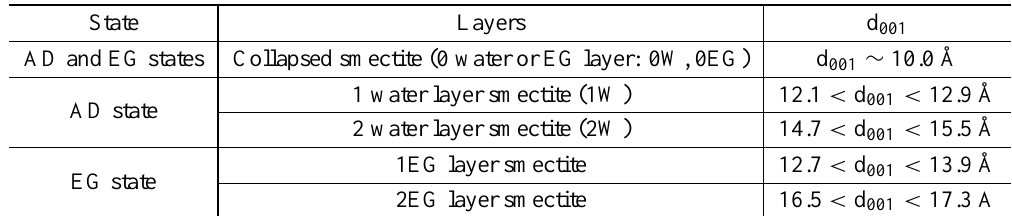
Structural parameters of the different types of layers considered in the XRD pattern calculation of the mixed-layered minerals (Sato et al.